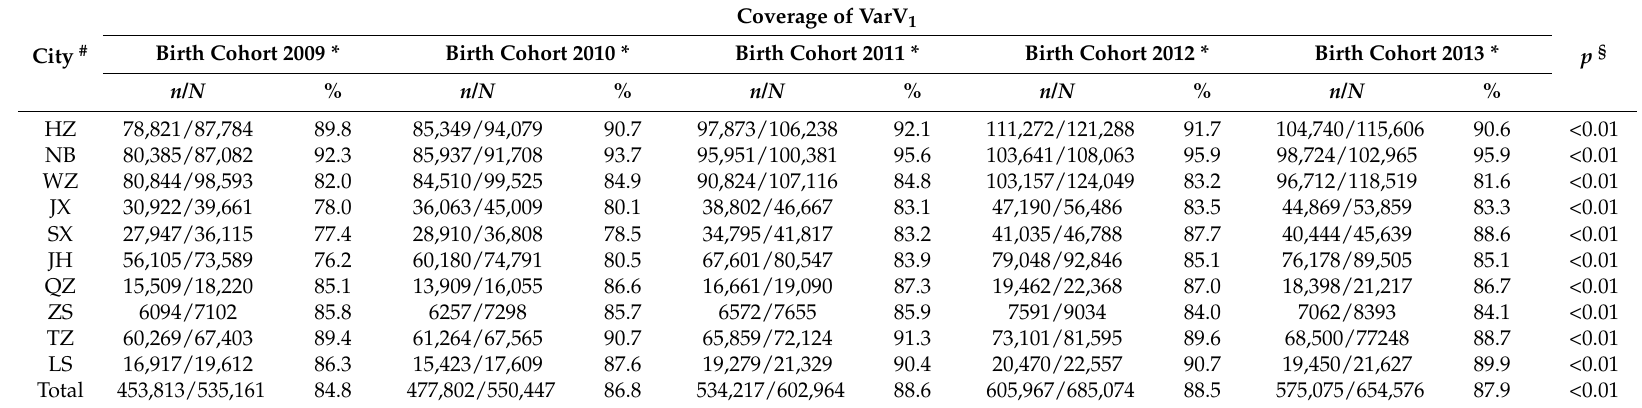
Table 1. Vaccination coverage of VarV 1 of children aged 4–6 years in Zhejiang province, by city.